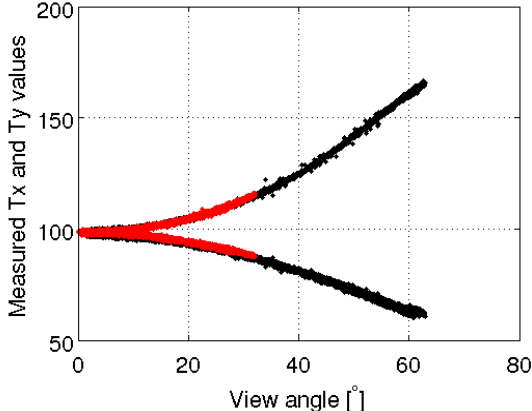
Figure 13. Tb (K) measured for the X and Y polarizations, for both nadir (red) and slant (black) antennas, as a function of incidence